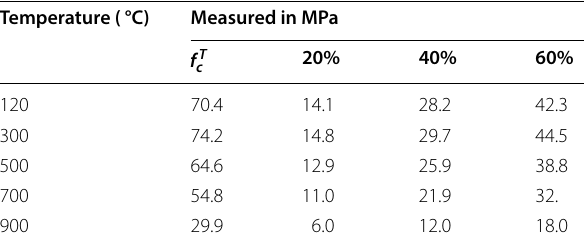
Table 4 Stress levels of PRPC for STC testing.